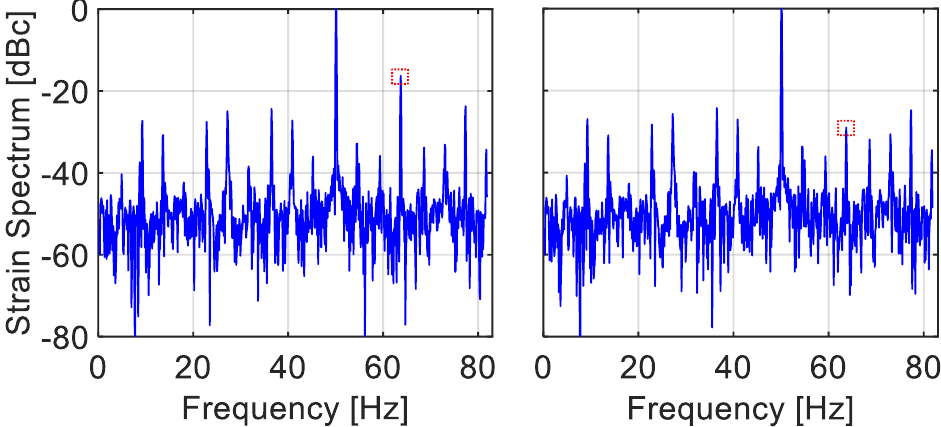
Figure 10. ( Left ) Hamming-weighed FFT spectrum of raw BFS vs. time 50 Hz vibration data, obtained from the experimental setup of Figure 8. The scan rate is 164 Hz, the scan range is 108 MHz and the vibration amplitude is 17 MHz, resulting in 𝑓 𝑠𝑖𝑔𝑛𝑎𝑙 /𝑓 𝑠𝑐𝑎𝑛 = 0.3 and 𝜈 𝑠𝑖𝑔𝑛𝑎𝑙−𝑎𝑚𝑝 /𝜈 𝑠𝑐𝑎𝑛𝑠𝑝𝑎𝑛 = 0.16, respectively. Note the strong (−16.3 dB) second harmonic (dotted square), occurring at the folded frequency of 64 Hz (=164/2 − (2 × 50 − 164/2)). It is due to the fact the FFT algorithm implicitly treats its input temporally non-uniform data as uniform (The other peaks are folded higher harmonics). ( Right ) Using the measured instants of acquisition, { τ n } N − 1 , and the procedure of spline interpolation of Section 3, the second harmonic is significantly attenuated to − 29 dB (dotted square). Record duration is 9 s.